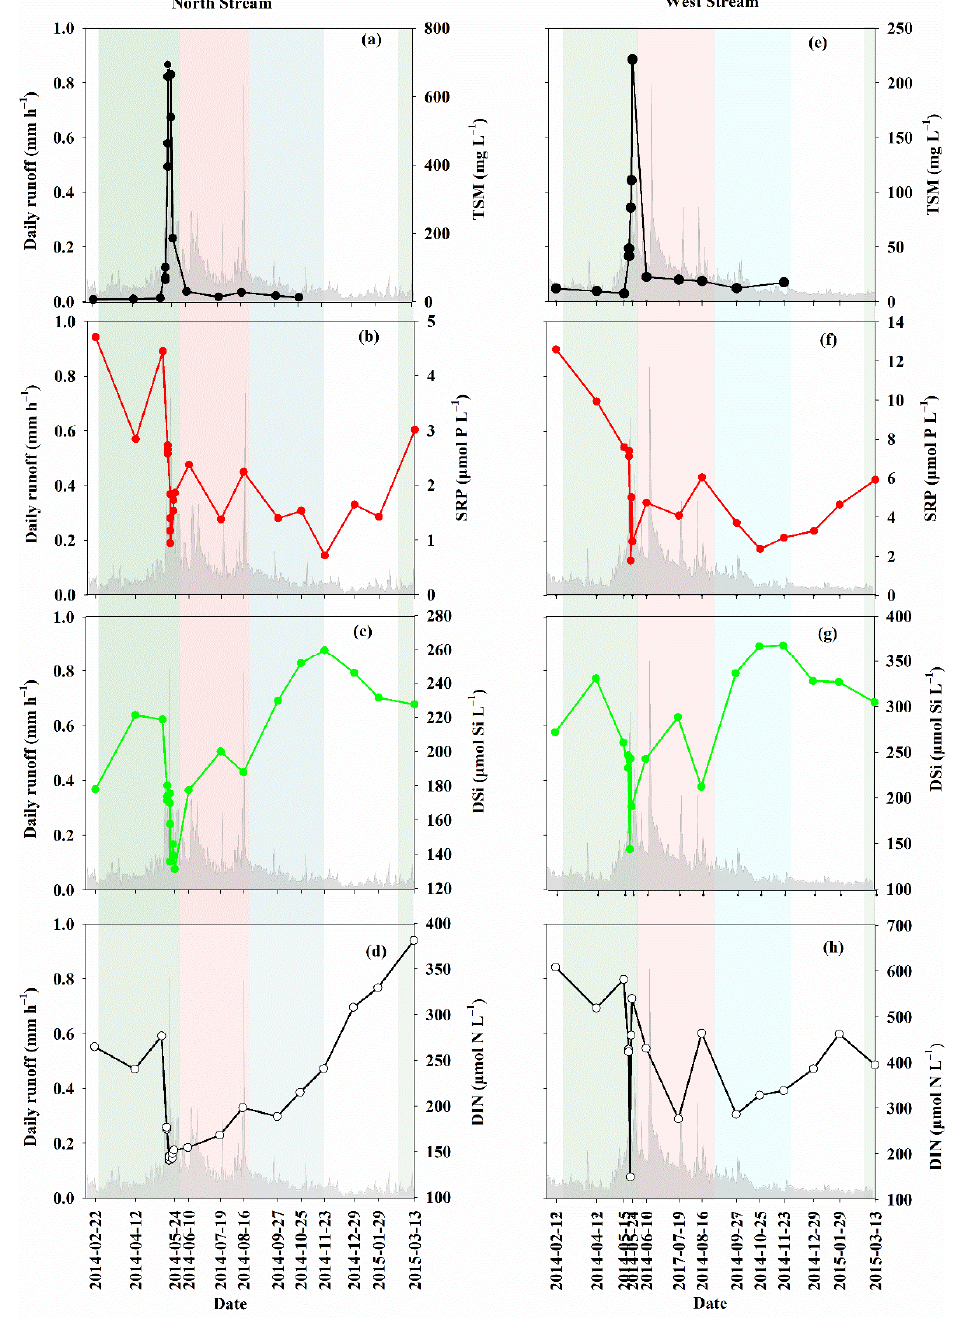
Figure 3. Temporal variations in riverine TSM and nutrients in the NS ( a – d ) and the WS ( e – h ): ( a , e ) are TSM concentrations, ( b , f ) are SRP concentrations, ( c , g ) are DSi concentrations and ( d , h ) are DIN concentrations. The gray shading represents the daily average runoff. The green, red, blue and white bars indicate spring, summer, autumn and winter,